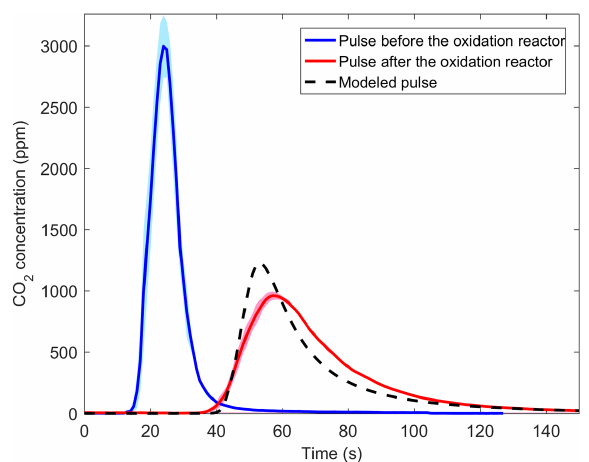
Figure 3. Modeled and measured residence time distributions with and without secondary excess flow and UV lights. The shaded area shows the standard deviation of three